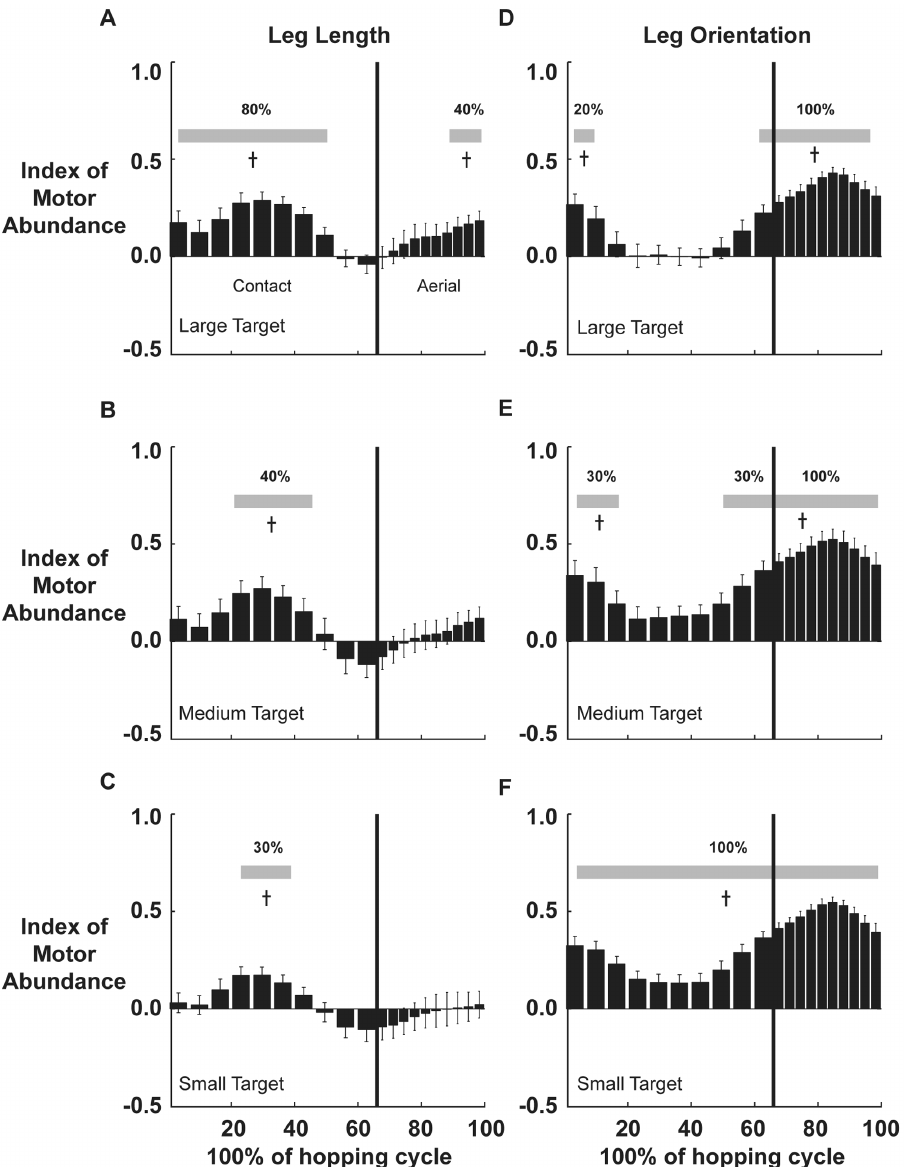
Figure 3. Variance structure over the hop cycle. 3. Index of Motor Abundance (IMA) (a–c) for leg length stabilization across three target conditions. (d–f) IMA for leg orientation stabilization across three target conditions. Bars are the averaged IMA for 10% intervals in contact and aerial phase. (n=11, 6 1 standard deviation). The duration of leg length stabilization decreased with decreasing target size but remained stabilized at midstance. The duration of leg orientation stabilization increased with decreasing target size. Gray bars denote period where IMA was significantly greater than 0 (p , 0.01). partitioning of segment angle variance. The control condition IMA data of our current study, hopping at 2.2 Hz in the large target was similar to hopping in place with no target when Leg orientation and leg length are low degree of freedom compared with previous IMA findings for 2.2 Hz [10]. Peak performance variables that are stabilized through a high dimen- periods of stabilization for leg orientation and leg length occurred sional kinematically redundant set of limb segments. In turn, at similar points in the hopping cycle as with no target hopping deviations of the segment angles can have a significant effect on leg (Figure 3a and 3d, Auyang et al. 2009). By constraining foot orientation and leg length trajectories. To approach having placement through smaller target sizes, we placed greater invariant limb kinematics over many hop cycles, one strategy importance on achieving an invariant leg orientation trajectory could be to minimize the total variance of all segment angles when and less importance on having a consistent leg length. the task is made more constrained [22,23]. Our subjects, however, actually increased total segment angle variance when target size